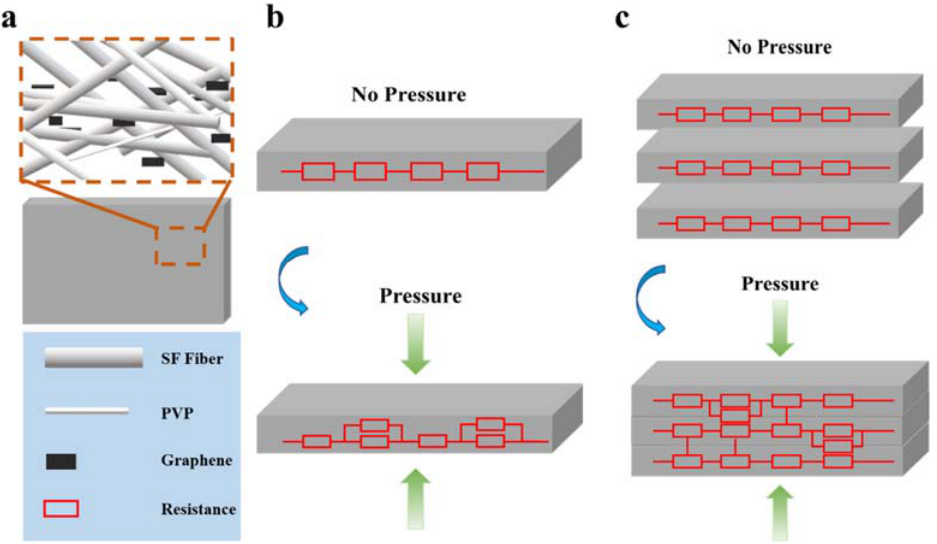
Figure 10. Working principle of SF/Gr pressure sensor. ( a ) a circuit model to SF/Gr sensor, ( b ) schematic diagram of a sensor circuit composed of single layer SF/Gr membrane, ( c ) schematic diagram of a sensor circuit composed of multilayer SF/Gr membranes.